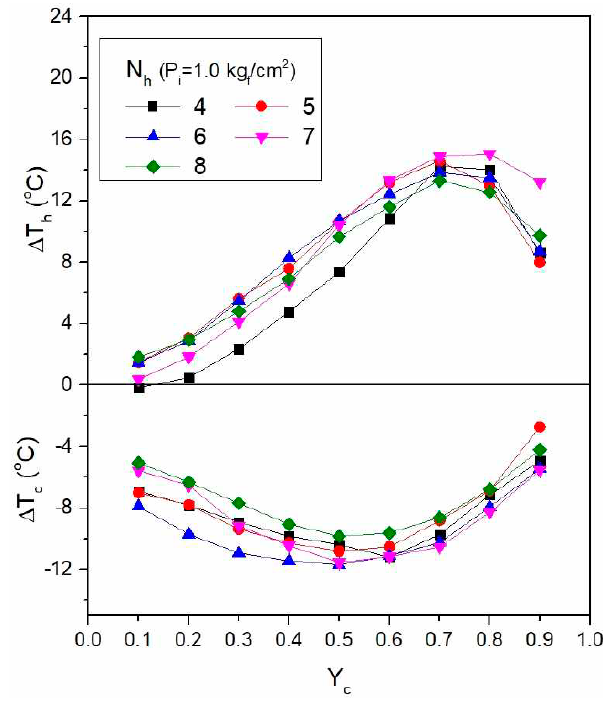
Figure 12. Temperature differences ∆ T h and ∆ T c according to inlet pressure (P i ) 1.0 kgf/cm 2 .